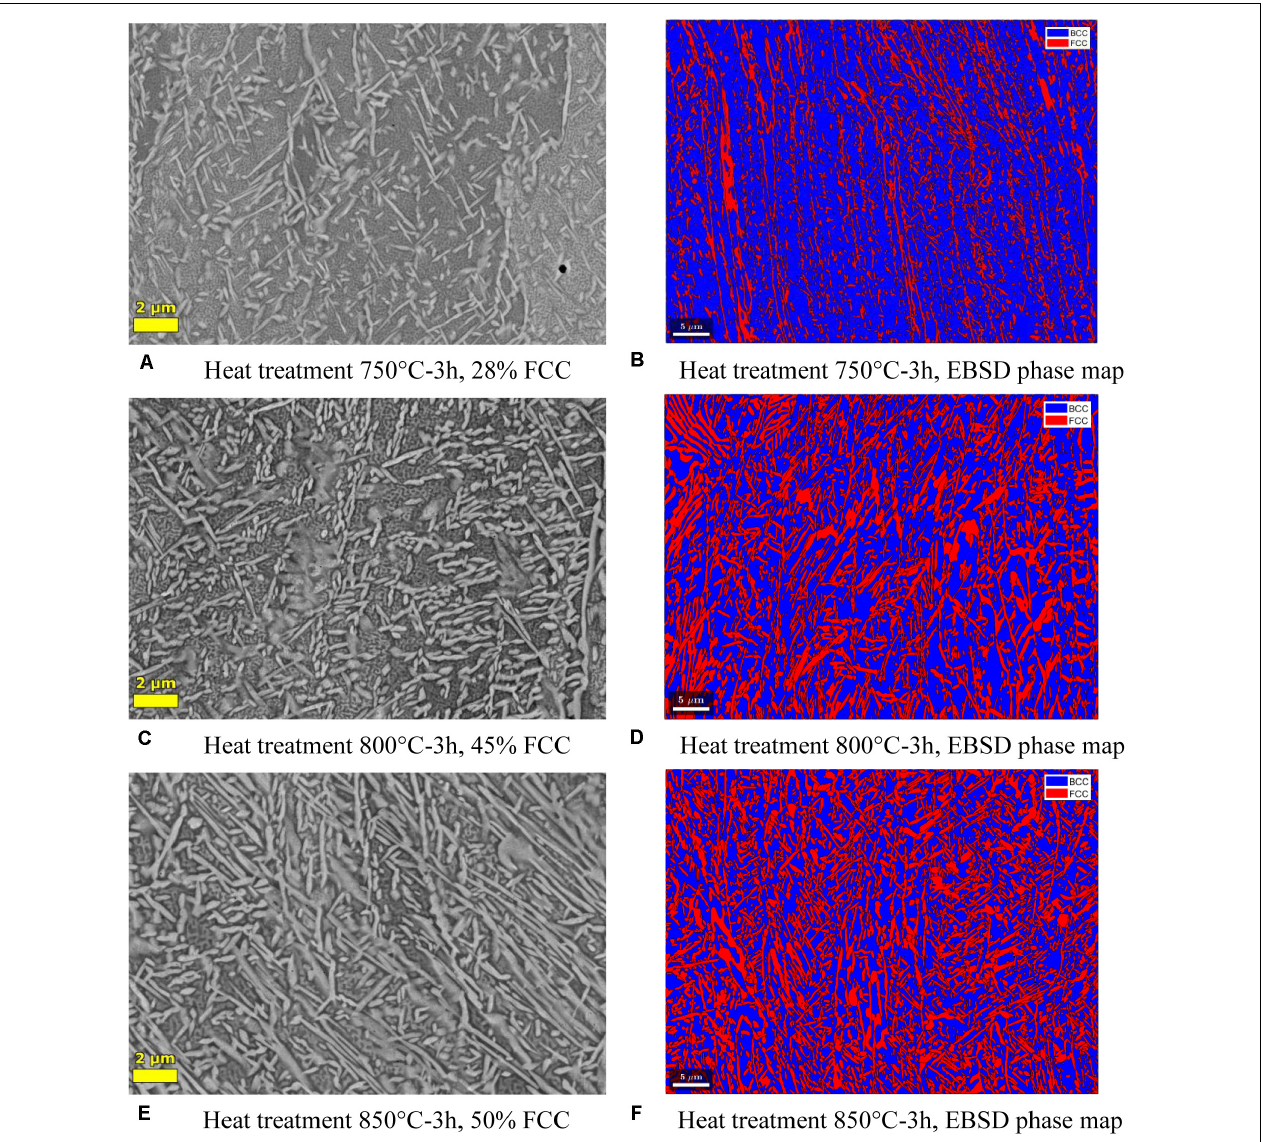
FIGURE 6 | SEM micrographs and EBSD phase maps of the AlCrFe 2 Ni 2 microstructures after heat treatment at (A,B) 750 ◦ C, (C,D) 800 ◦ C, and (E,F) 850 ◦ C for 3 h. The percentage of the FCC phase is also included in the labels for each heat treatment condition.